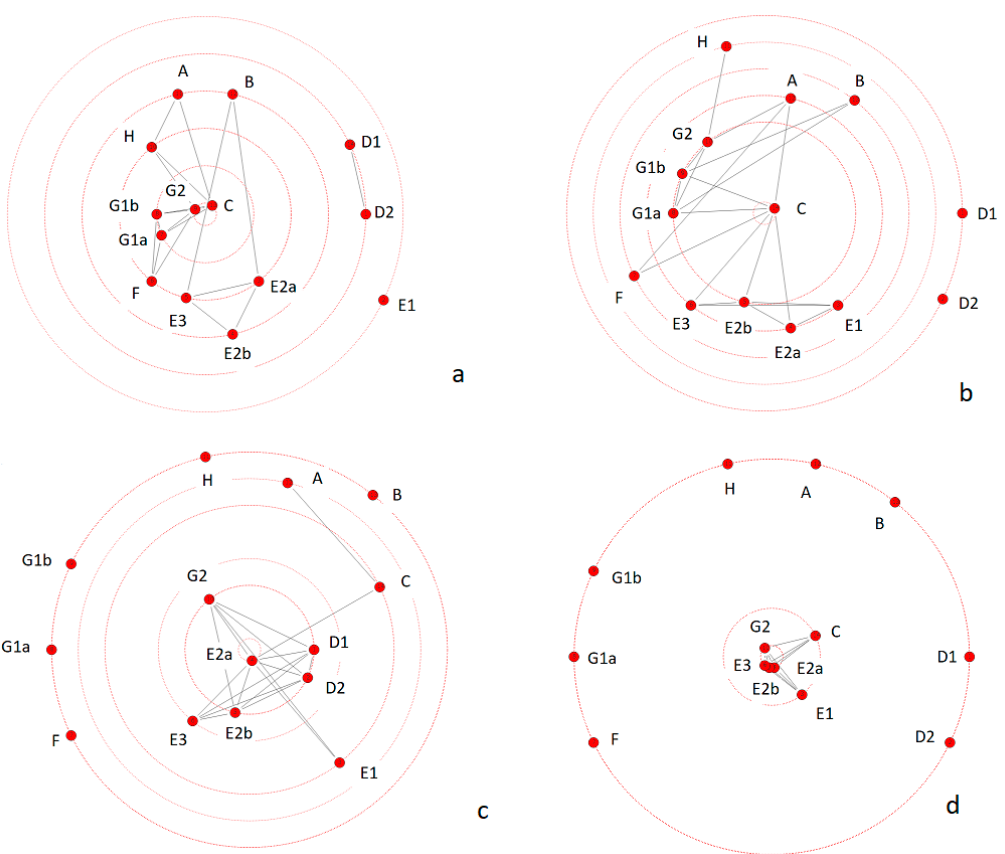
Figure 5. Radial representation of the networks showing the node centrality of concepts and sub-concepts per age group: ages 20–30 ( a ), 30–40 ( b ), 40–50 ( c ), and 50–60 ( d ) for question Q 1 .